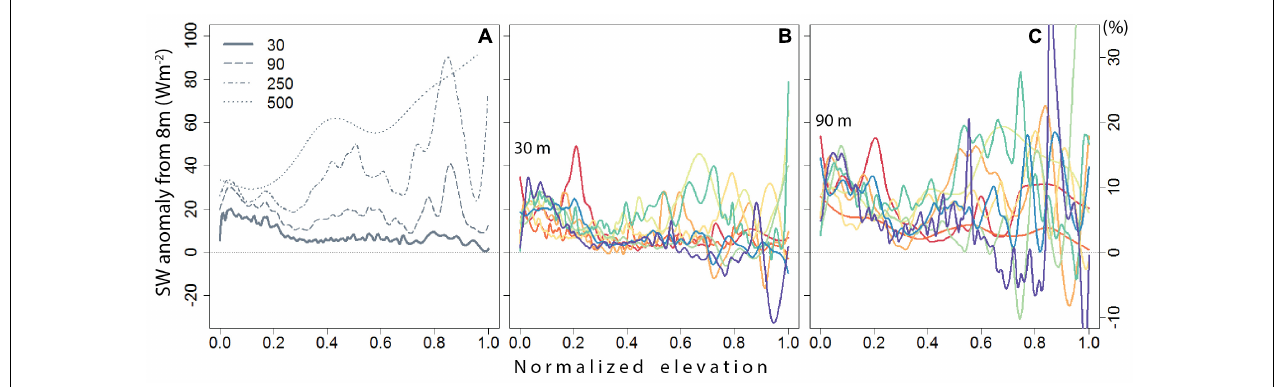
FIGURE 4 | Shortwave anomalies (due to the combined effect of terrain attributes) averaged across all 10 glaciers in the region as resolution is coarsened to 30-, 90-, 250-, and 500-m resolutions (A) . Panels (B,C) show the SW anomaly values at 30- and 90-m resolutions (respectively) for each glacier in the Everest region. Note that the SW anomalies vary drastically from glacier to glacier. The change in irradiance from terrain attributes accounts for variability in irradiance across elevation, thus we show absolute anomalies (left y-axis) in conjunction with percent changes (right y-axis) relative to the mean irradiance over the glaciers.